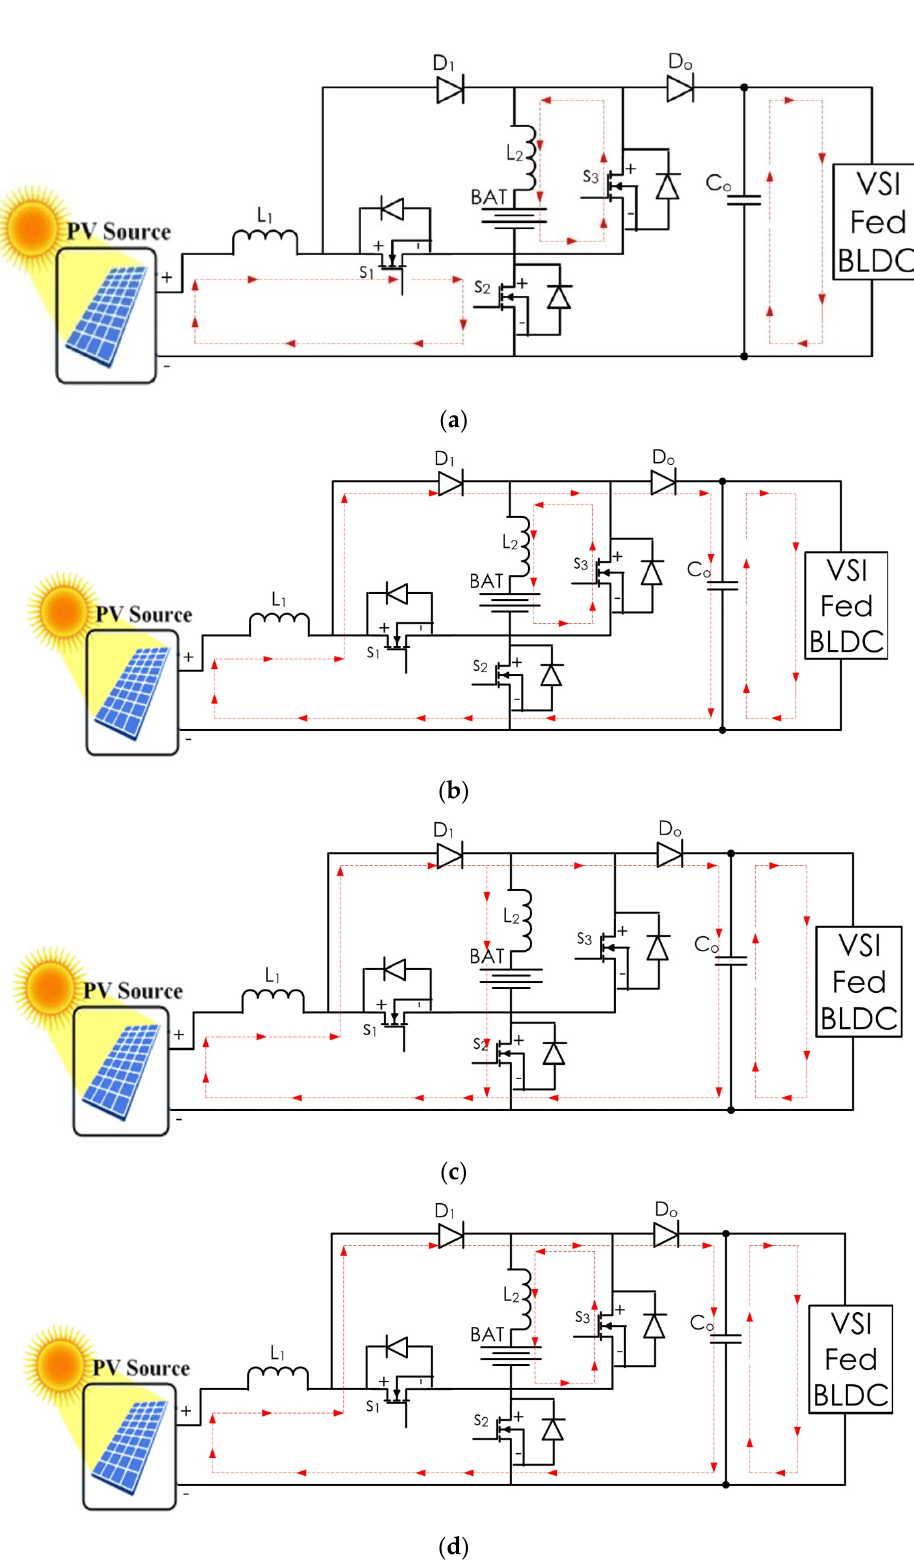
Figure 6. Comparable circuit: ( a ) Mode II(a); ( b ) Mode II(b); ( c ) Mode II(c); ( d ) Mode II(d). Mode II (b): In this mode, switches ( S 1 ) and ( S 2 ) will be in the “OFF” position. Diodes ( D ) , ( SD ) , and ( SD ) are forward biased. Figure 6b illustrates the suggested converter’s equivalent circuit. From the PV source, input side inductor (L 1 ) starts discharging, and current (i L1 ) increases. The inductor (L 2 ) of ESS and battery are starting to get charged